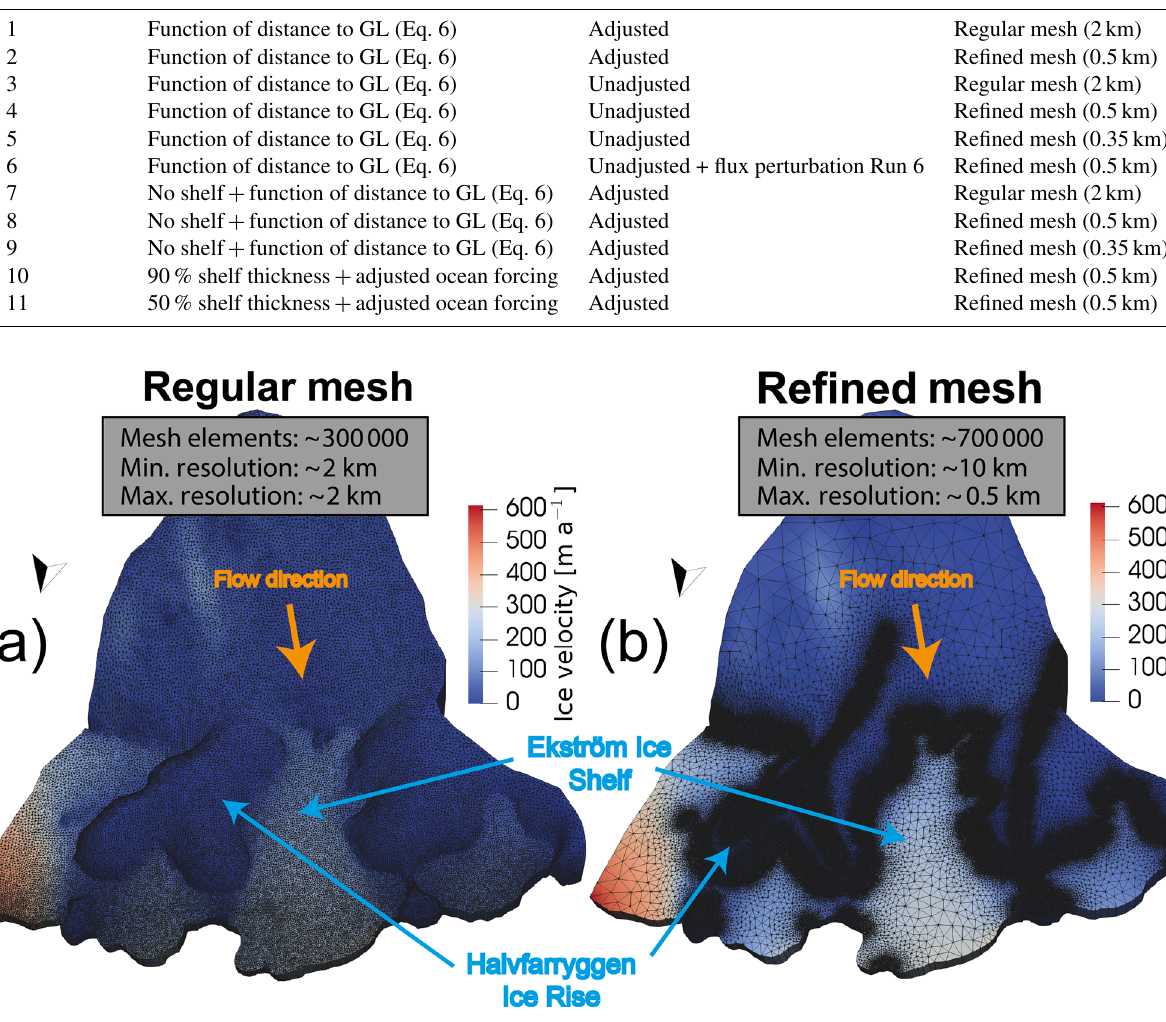
Figure 4. The 3-D plot of the model domain showing the two main mesh resolutions employed in this study. (a) shows uniform mesh of 2km resolution and (b) shows refined mesh in areas of interest such as the grounding line and the ice-rise divides. In these areas the mesh resolution is ∼ 500m and away from these regions the mesh resolution increases to